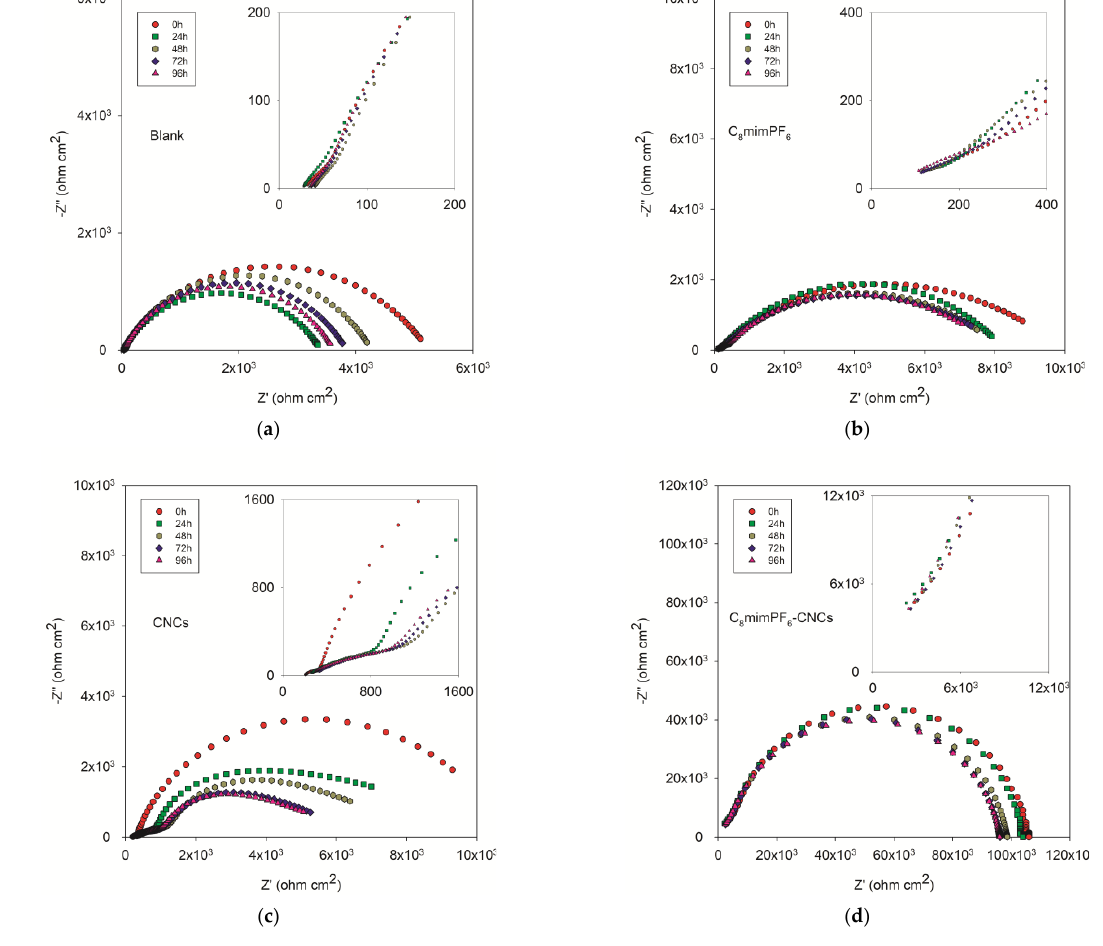
Figure 2. Nyquist impedance plots of coated samples after 96 h of immersion in 3.5 wt% NaCl solution. ( a ) Blank (neat PMMA-co-PBA coating), ( b ) C 8 mimPF 6 (PMMA-co-PBA coating with 10 wt% C 8 mimPF 6 ), ( c ) CNCs (PMMA-co-PBA coating with 0.5 wt% CNCs), and ( d ) C 8 mimPF 6 -CNCs